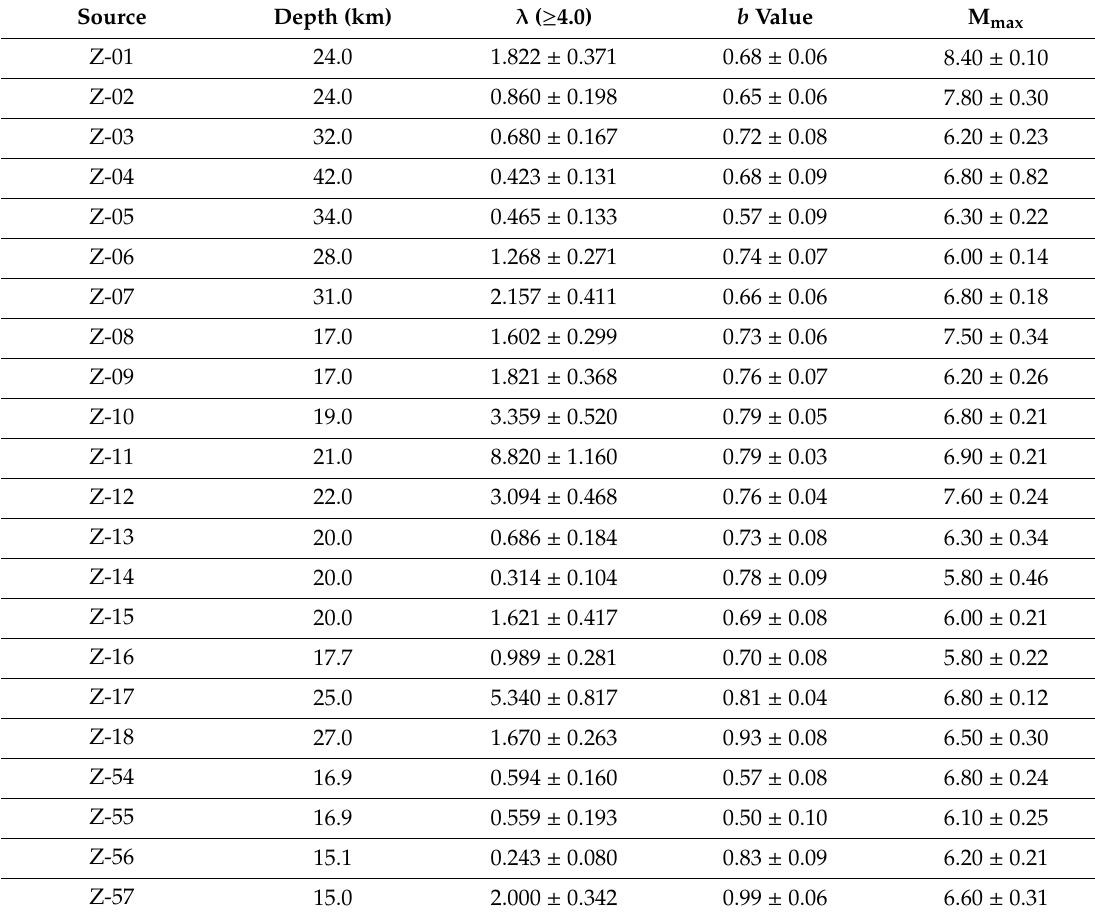
Table 4. Seismicity parameters (seismogenic depth, annual rate of earthquakes above Mw 4.0, b -value, maximum expected magnitude) for the model by El-Hussain et al.